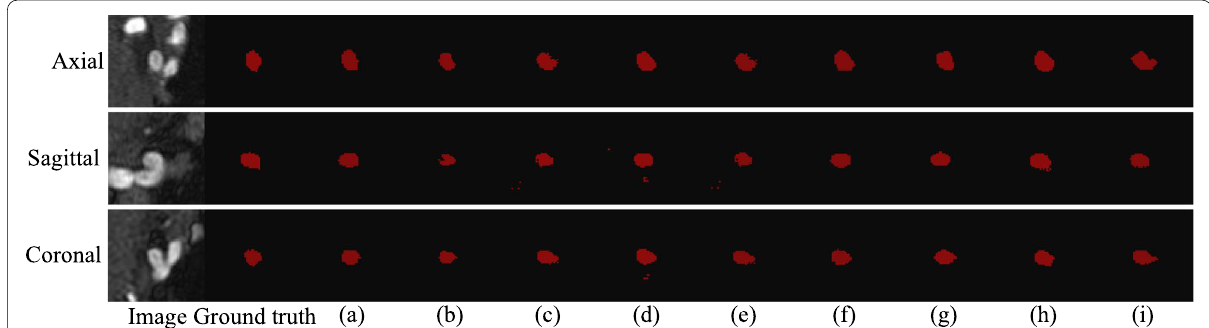
Fig. 6 Prediction maps for the models with different components, on the MICCAI 2020 ADAM testing set. The first column is the MRA image of an aneurysm, while the second column shows the manually obtained marking mask. a The proposed model; b U-Net; c U-Net with the dense block; d